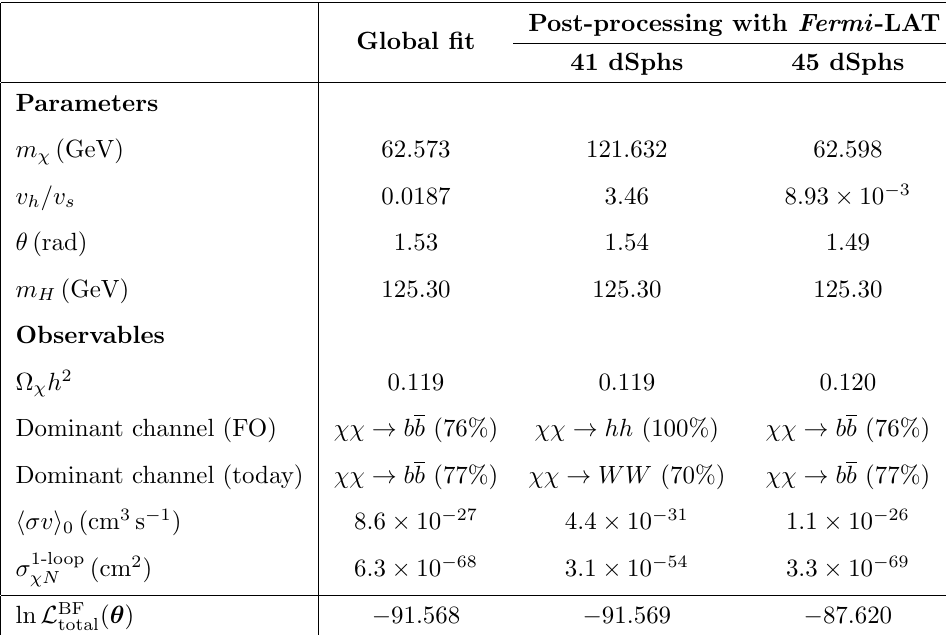
Table 2 . A summary of the best-(cid:12)t (BF) points, key DM observables (the DM relic abundance, the dominant annihilation channel during freeze-out (FO) and today, the DM annihilation cross section today and the one-loop DM-nucleon cross section) and total log-likelihood ln our global (cid:12)t ( column 1 ), and after post-processing our samples with Fermi -LAT likelihood with 41 ( column 2 ) and 45 ( column 3 ) dwarf spheroidal (dSph) galaxies. In (cid:12)gure 1, we show our PLR plots in six 2D planes spanned by all combinations of four model parameters. These are generated using pippi v2.0 [83]. In each plane, model parameters that are not shown are pro(cid:12)led over. The 1 (cid:27) (2 (cid:27) ) CL contours are marked by solid (dashed) lines. The best-(cid:12)t point is shown as a red star; it is also summarised in column 1 of table 2.